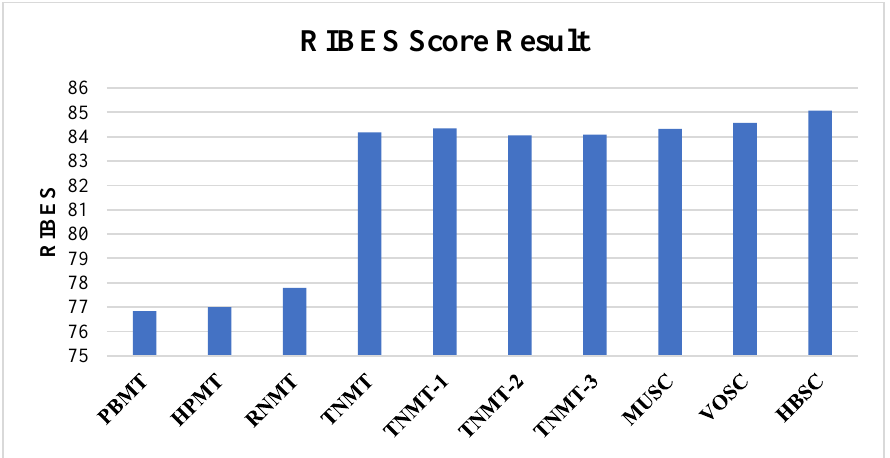
Figure 5. Translation results (RIBES score) for the hybrid framework.